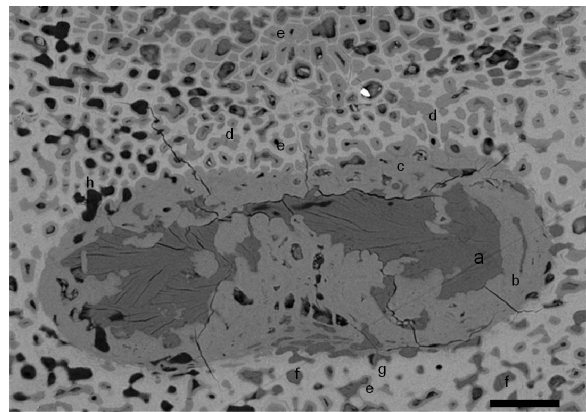
Fig. 2. SEM BSE image of coralline alga (sample 302) showing infilled cells within cell wall structure (top), and a large concep- tacle (bottom) that is filled with magnesite (a) and protodolomite (b) , (c) . SEM-EDS spot analyses of conceptacle mineralisation (a) = 99.55, (b) = 59.75, (c) = 61.67mol% MgCO 3 . Original con- ceptacle fabric is ingrown by cells, now dolomitised, cell shapes are visible in dolomitic areas. Magnesite in-fill may be correlated with precursor organic content. Cells are either completely filled with protodolomite (d) , rimmed by protodolomite and filled to various degrees by magnesite (e) , or filled by only magnesite (f) . From these images it appears that dolomitisation spreads out from the cells into the cell wall (g) . Cell void of mineral in-fill (h) . Increased dolomi- tisation can be seen at the top of the figure compared to the base. These areas of dominance of one mineral phase over another ap- pear in patches throughout the section. Scale bar = 40µ. Legend see Fig. 1.